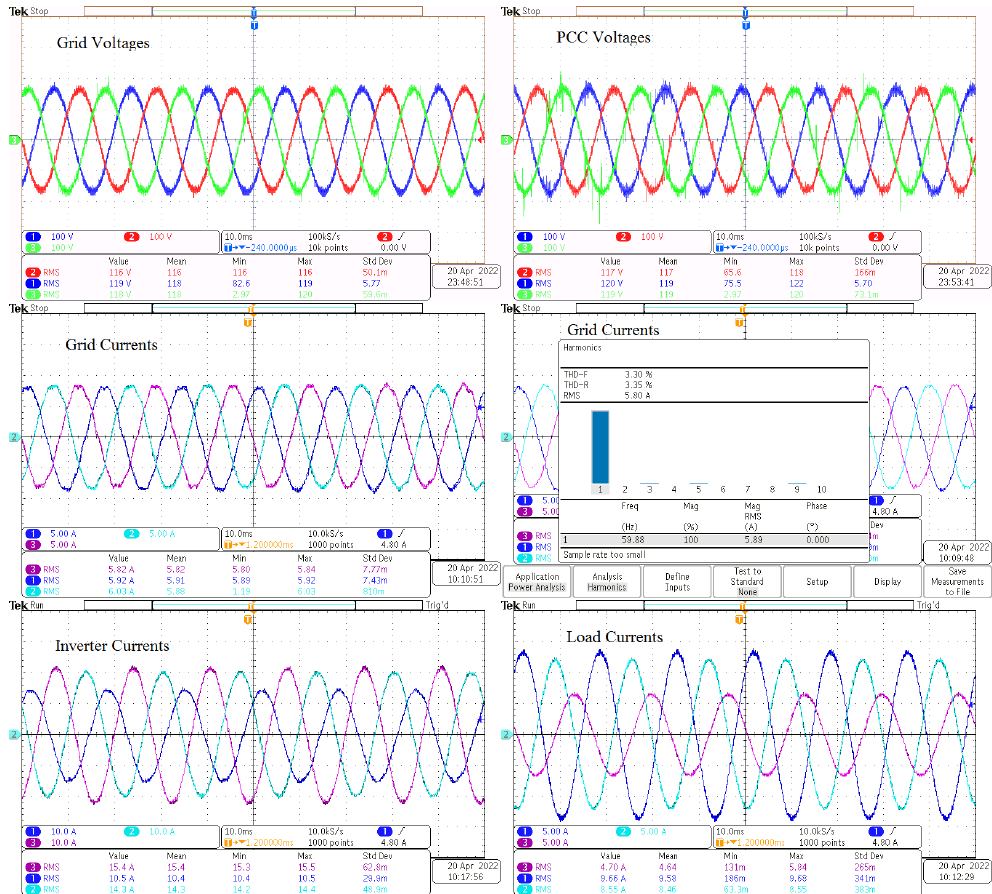
Figure 14. Experimental results at P = 2 kW, Q = 0 var using Tektronix MDO3024 oscilloscope.